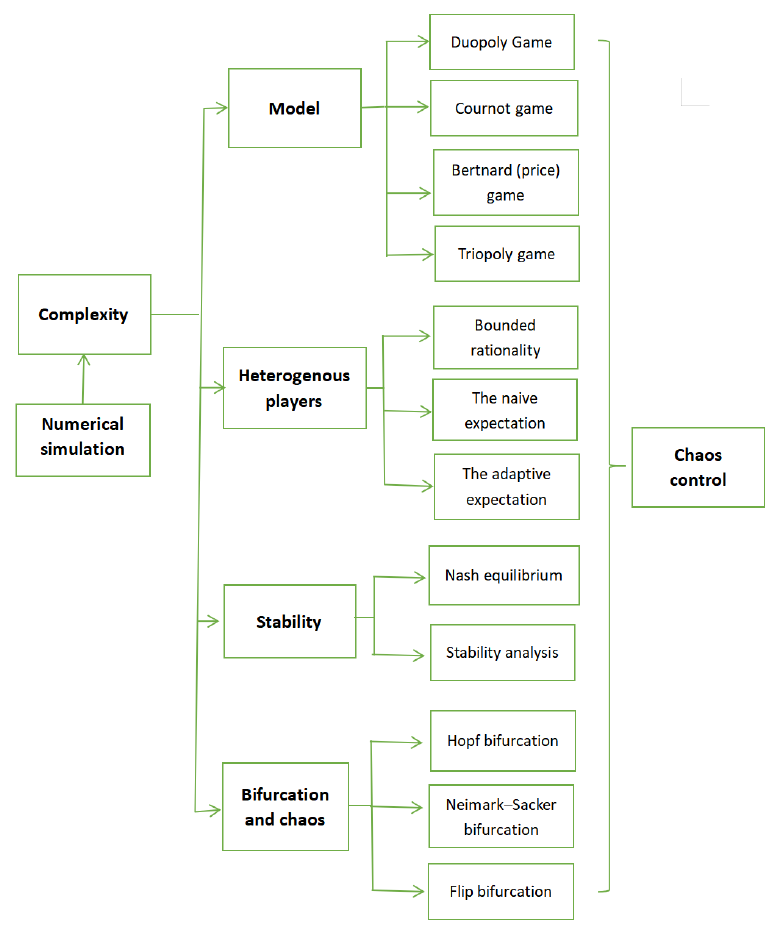
Figure 5. The logical relationship of hot